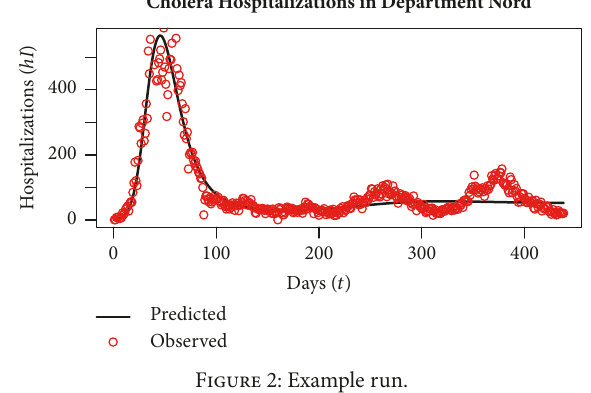
Figure 2: Example